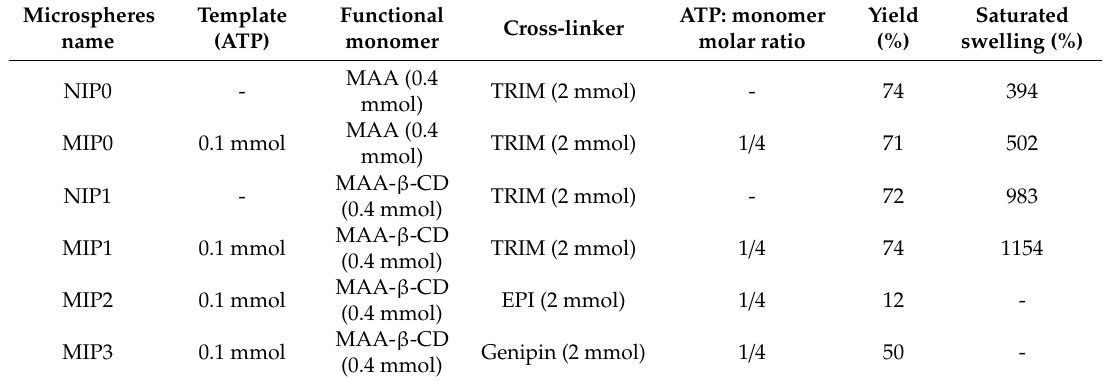
Table 2. Composition of the polymers.